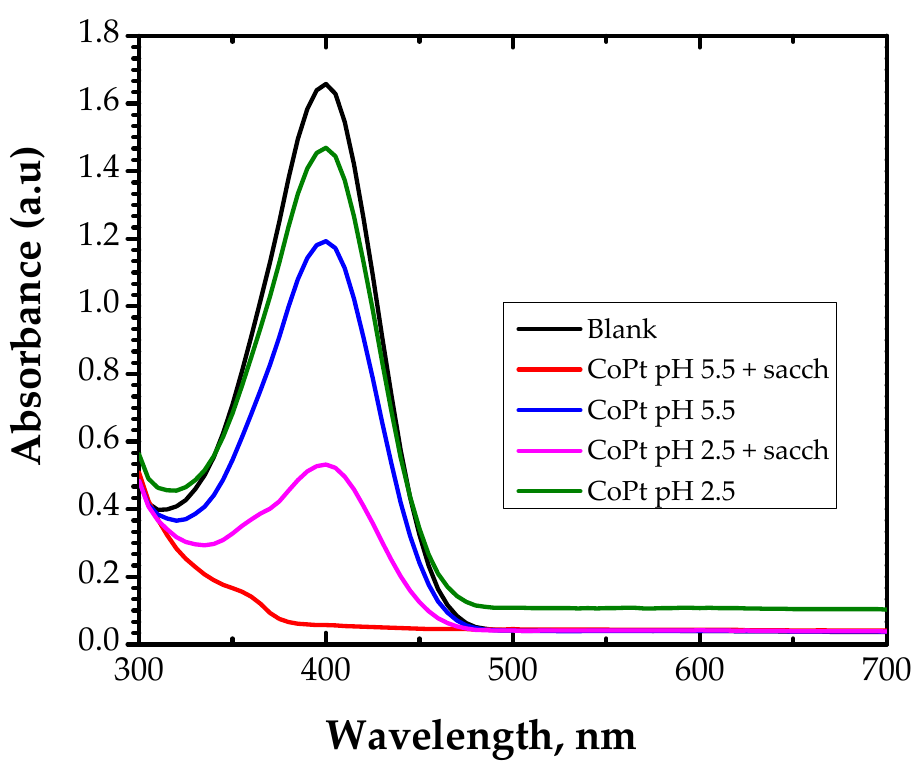
Figure 7. Absorption spectra of the conversion of 4-Nitrophanolate anion by the CoPt materials.